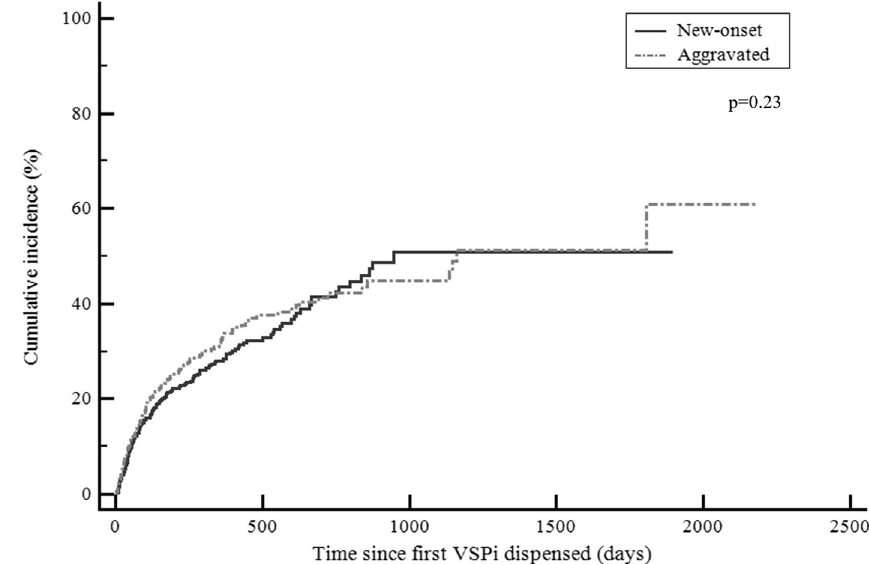
Fig. 2 Cumulative incidence of hypertension therapy